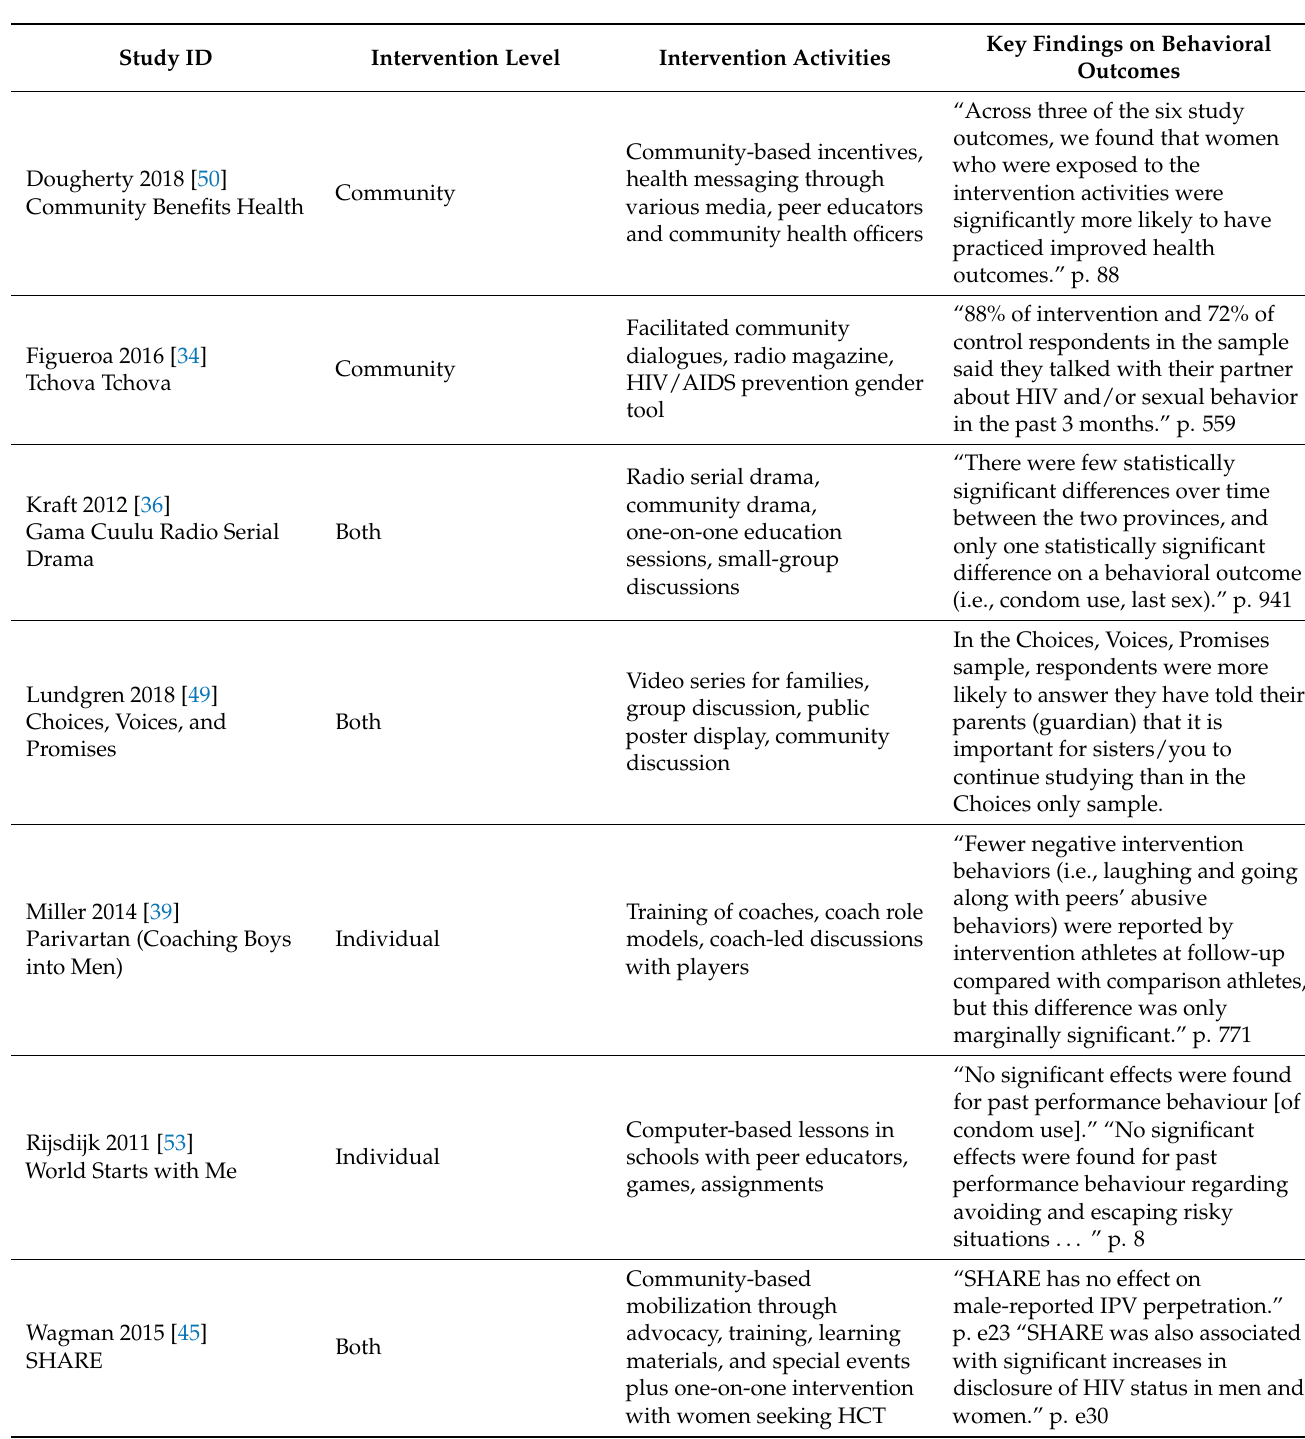
Table 5. Main findings on behavioral outcomes for primary studies assessed as having weak confi- dence in the